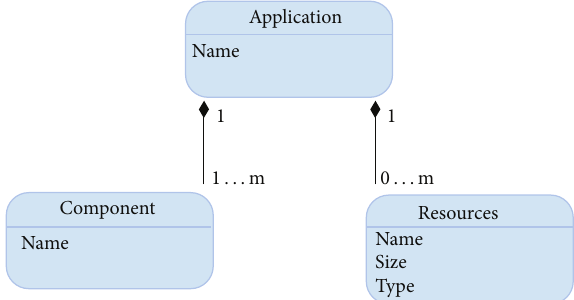
Figure 2: Application